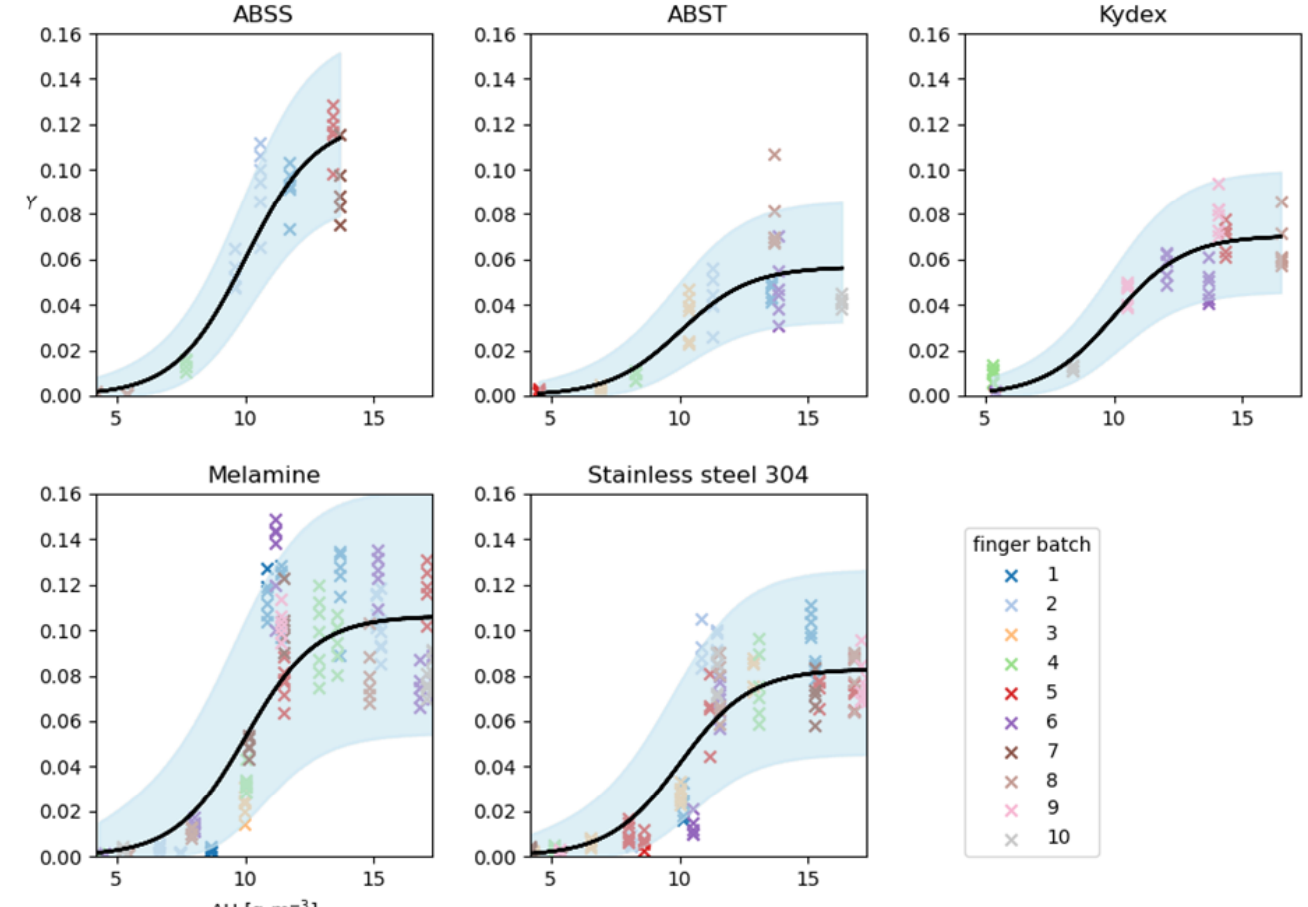
Figure 7. Posterior-predictive plot for the fitted non-linear regression model. Shaded region repre- sents the 2.5 to 97.5 percentile range, dependent upon AH, for the posterior-predicted distribution for the replicate data Y ̂ and the black lines show the mean predicted Y. The model was fitted to the aerosol deposition data only.